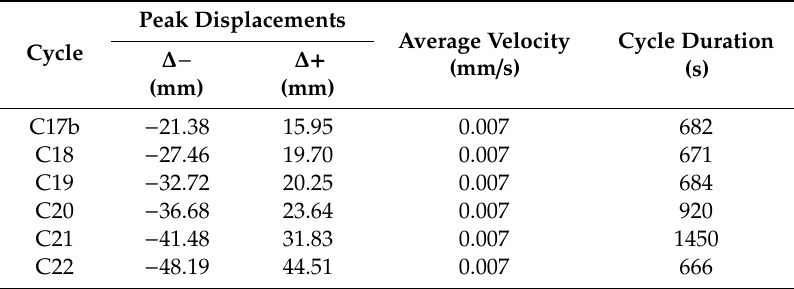
Table 5. Out-of-plane displacements captured by target 1386.